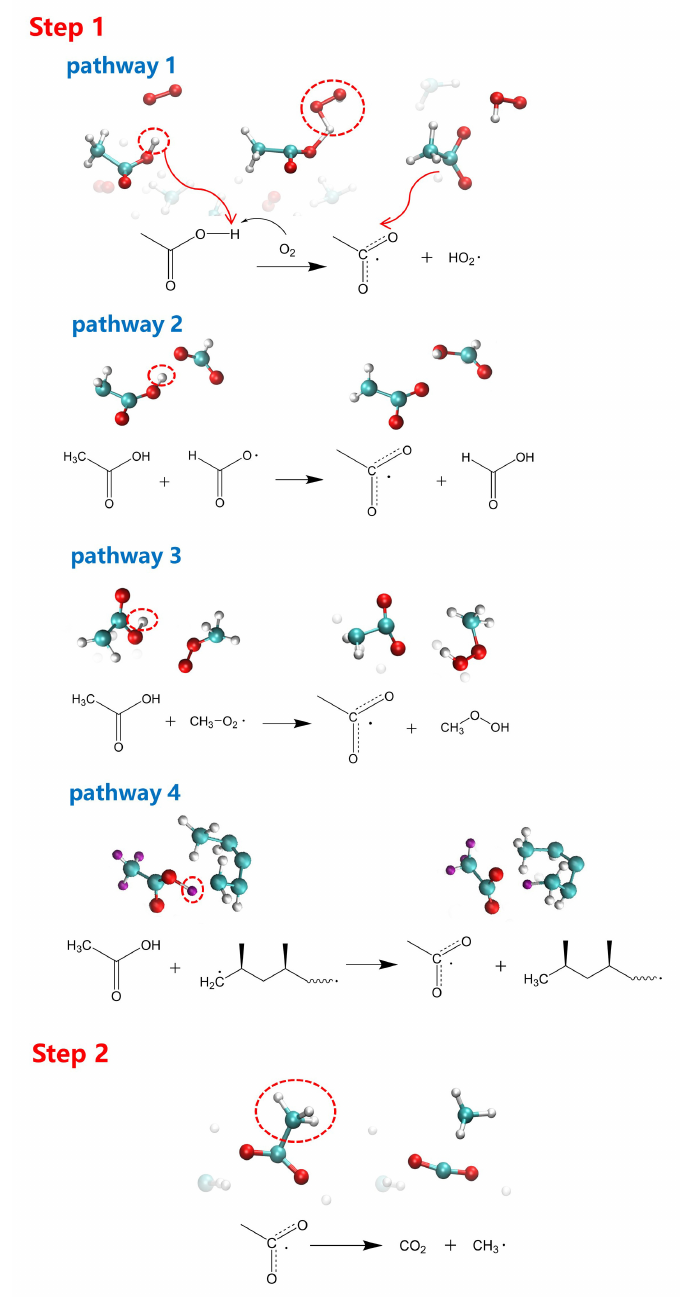
Figure 9. Main reaction paths of acetic acid during the aging